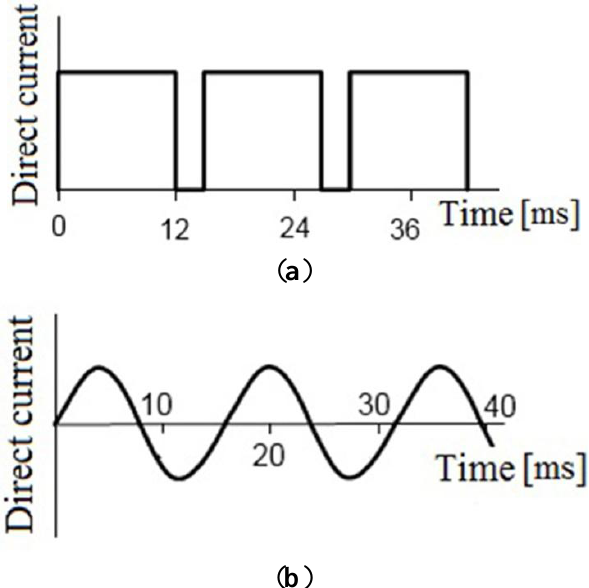
Figure 19. ( a ) SPS mode: 100 kN, 15 V, 5 kA, direct current, pulse period 14 ms, relative pulse duration 12:2; and ( b ) FAPAS mode: 100 kN, 10 В, 1.75 kA, alternating current 60 Hz. (Dijon-Belfort, France; Davis, CA,